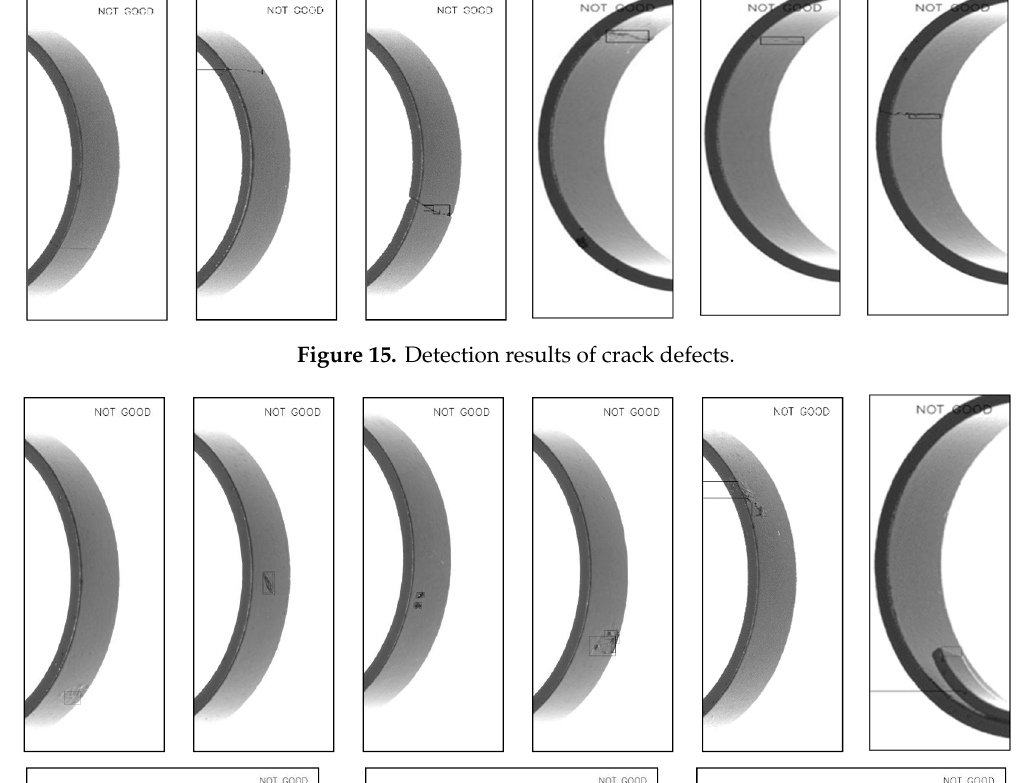
Figure 14. Detection results of fiber defects.